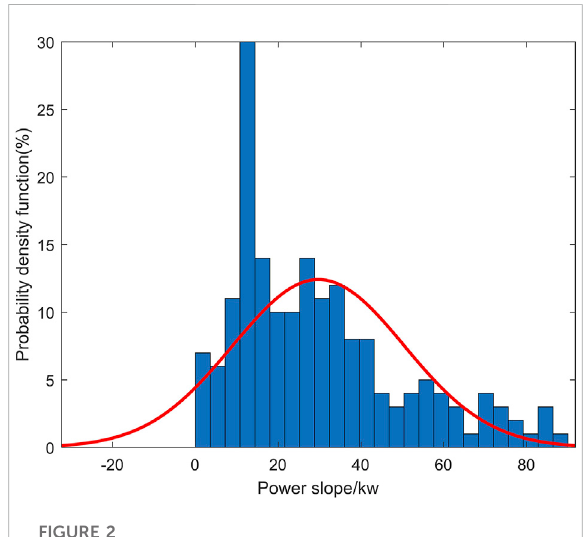
FIGURE 2 Probability density function of the power